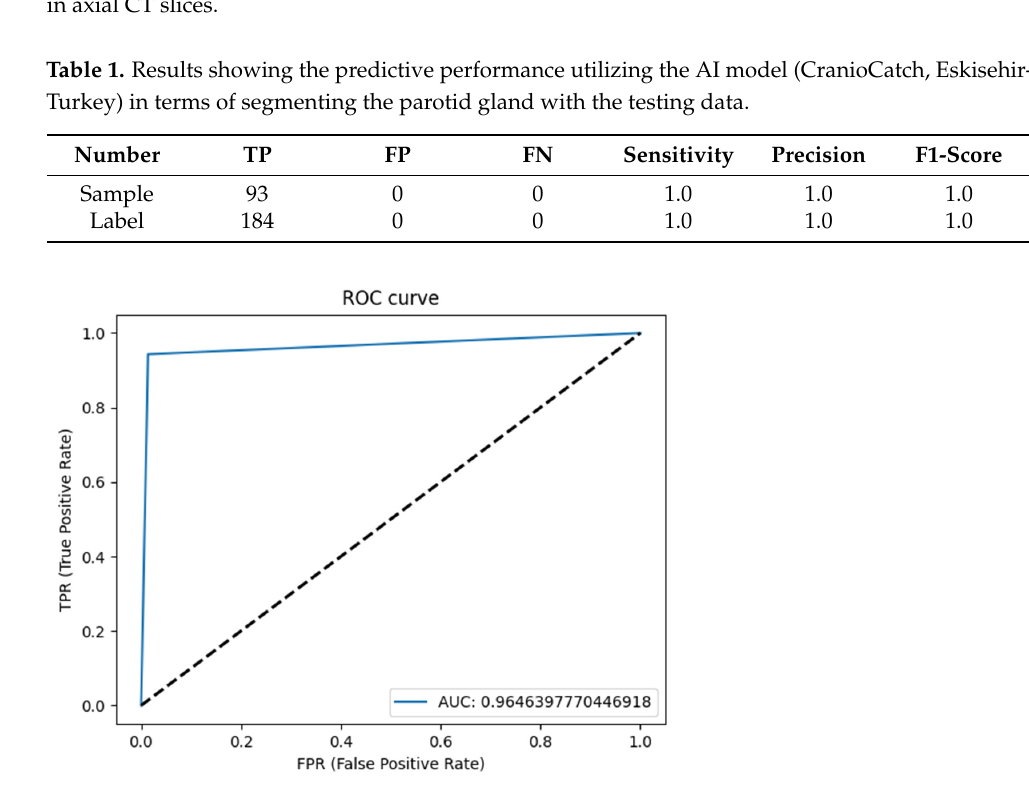
Figure 3. ROC Figure 3. ROC curve.